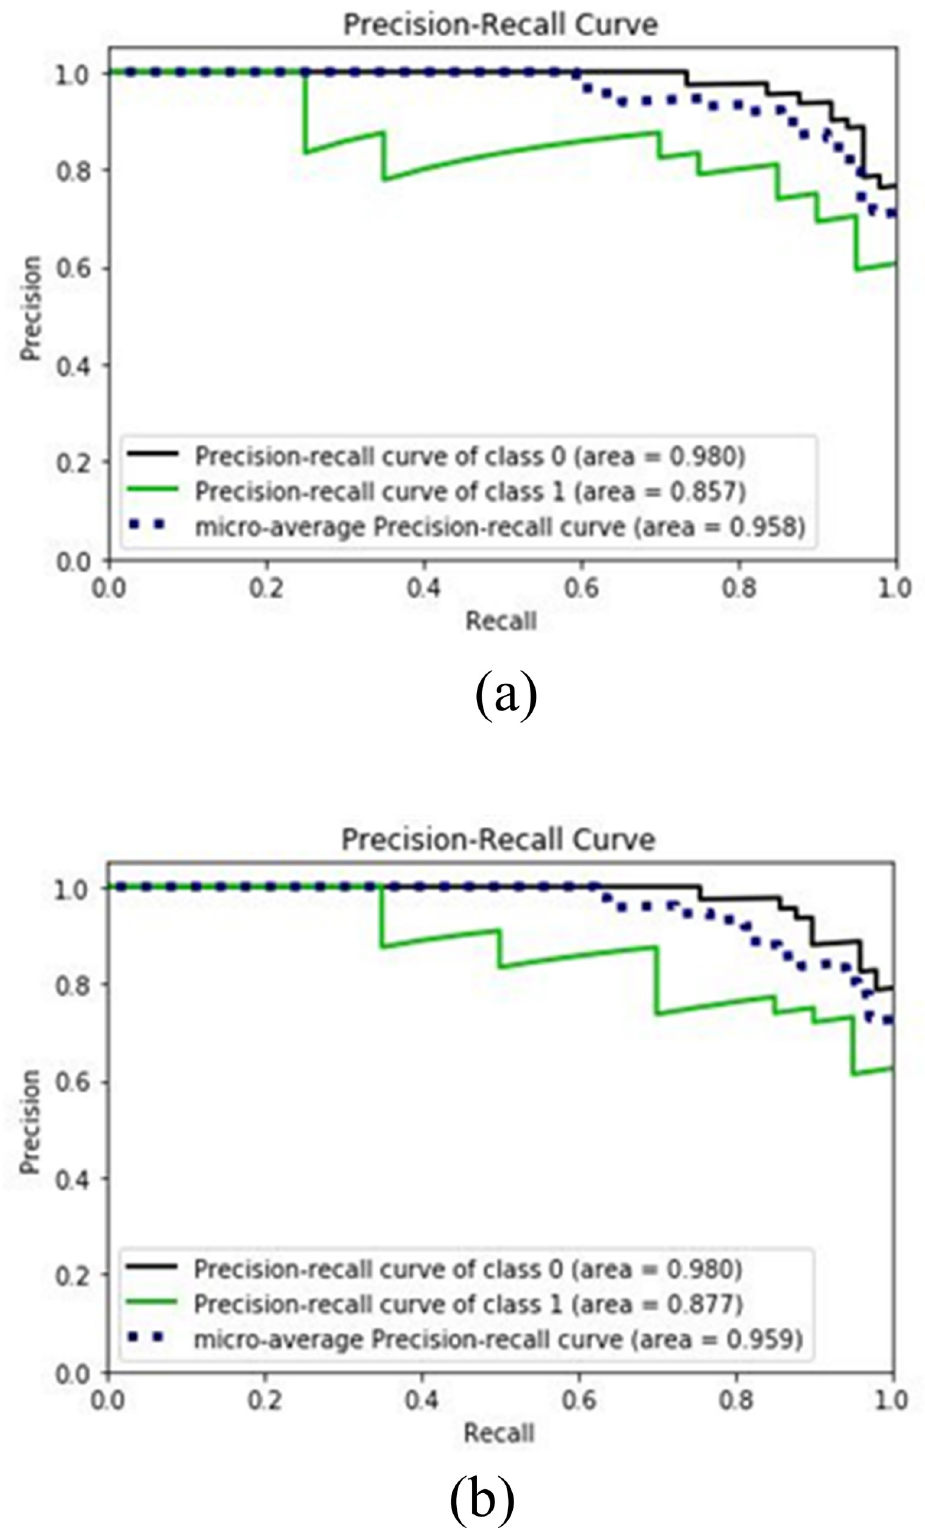
Fig 4. Precision-Recall Curves for (a) LR with 5 features (b) bagging LR with 5 features.